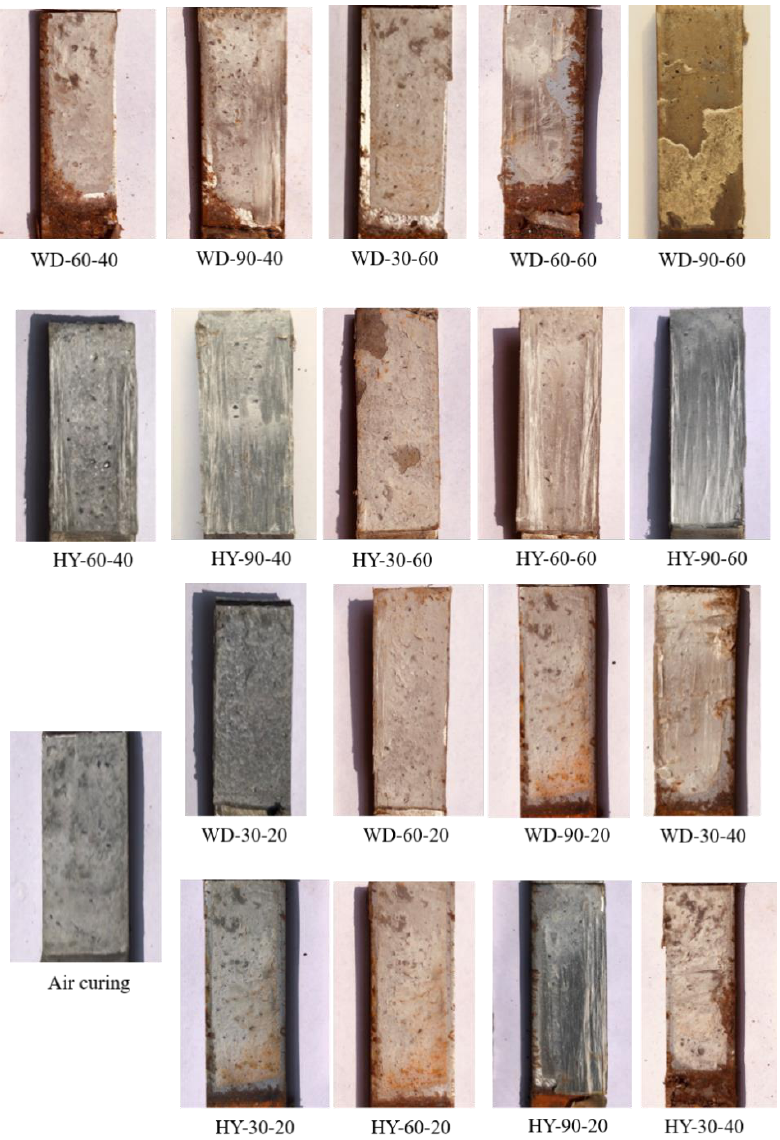
Figure 5. Photographs of the failure surfaces.